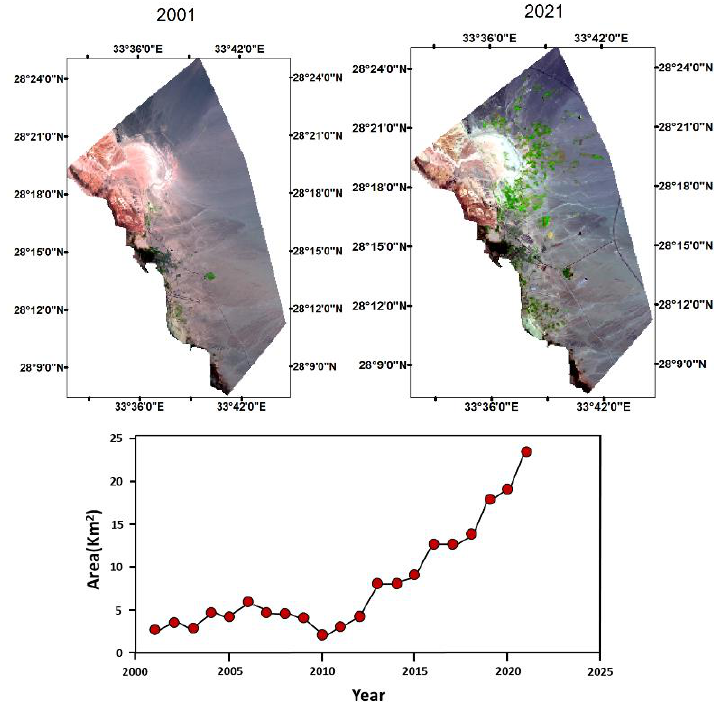
Figure 5. The upper part of the figure shows the increase in vegetated area from 2001 to 2021, captured by two Landsat 7 and 8 scenes. The lower part displays the gradual increase in the vegetated areas from 2001 to 2021, as captured by the NDVI index that is applied to Landsat 7 and 8 bands.